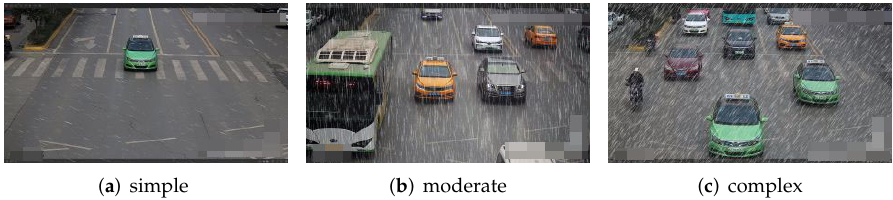
Figure 3. Examples of subset by PS . The three images are rendered by PS from simple, moderately complex, and complex scenes, respectively. We set the parameters’ noise, angle, distance, and Gaussian blur as ( 40%, − 20, 50, 0.5 ) , ( 106%, − 87, 48, 0.3 ) , ( 146%, 53, 33, 0.5 ) , respectively, for rendering the three rain